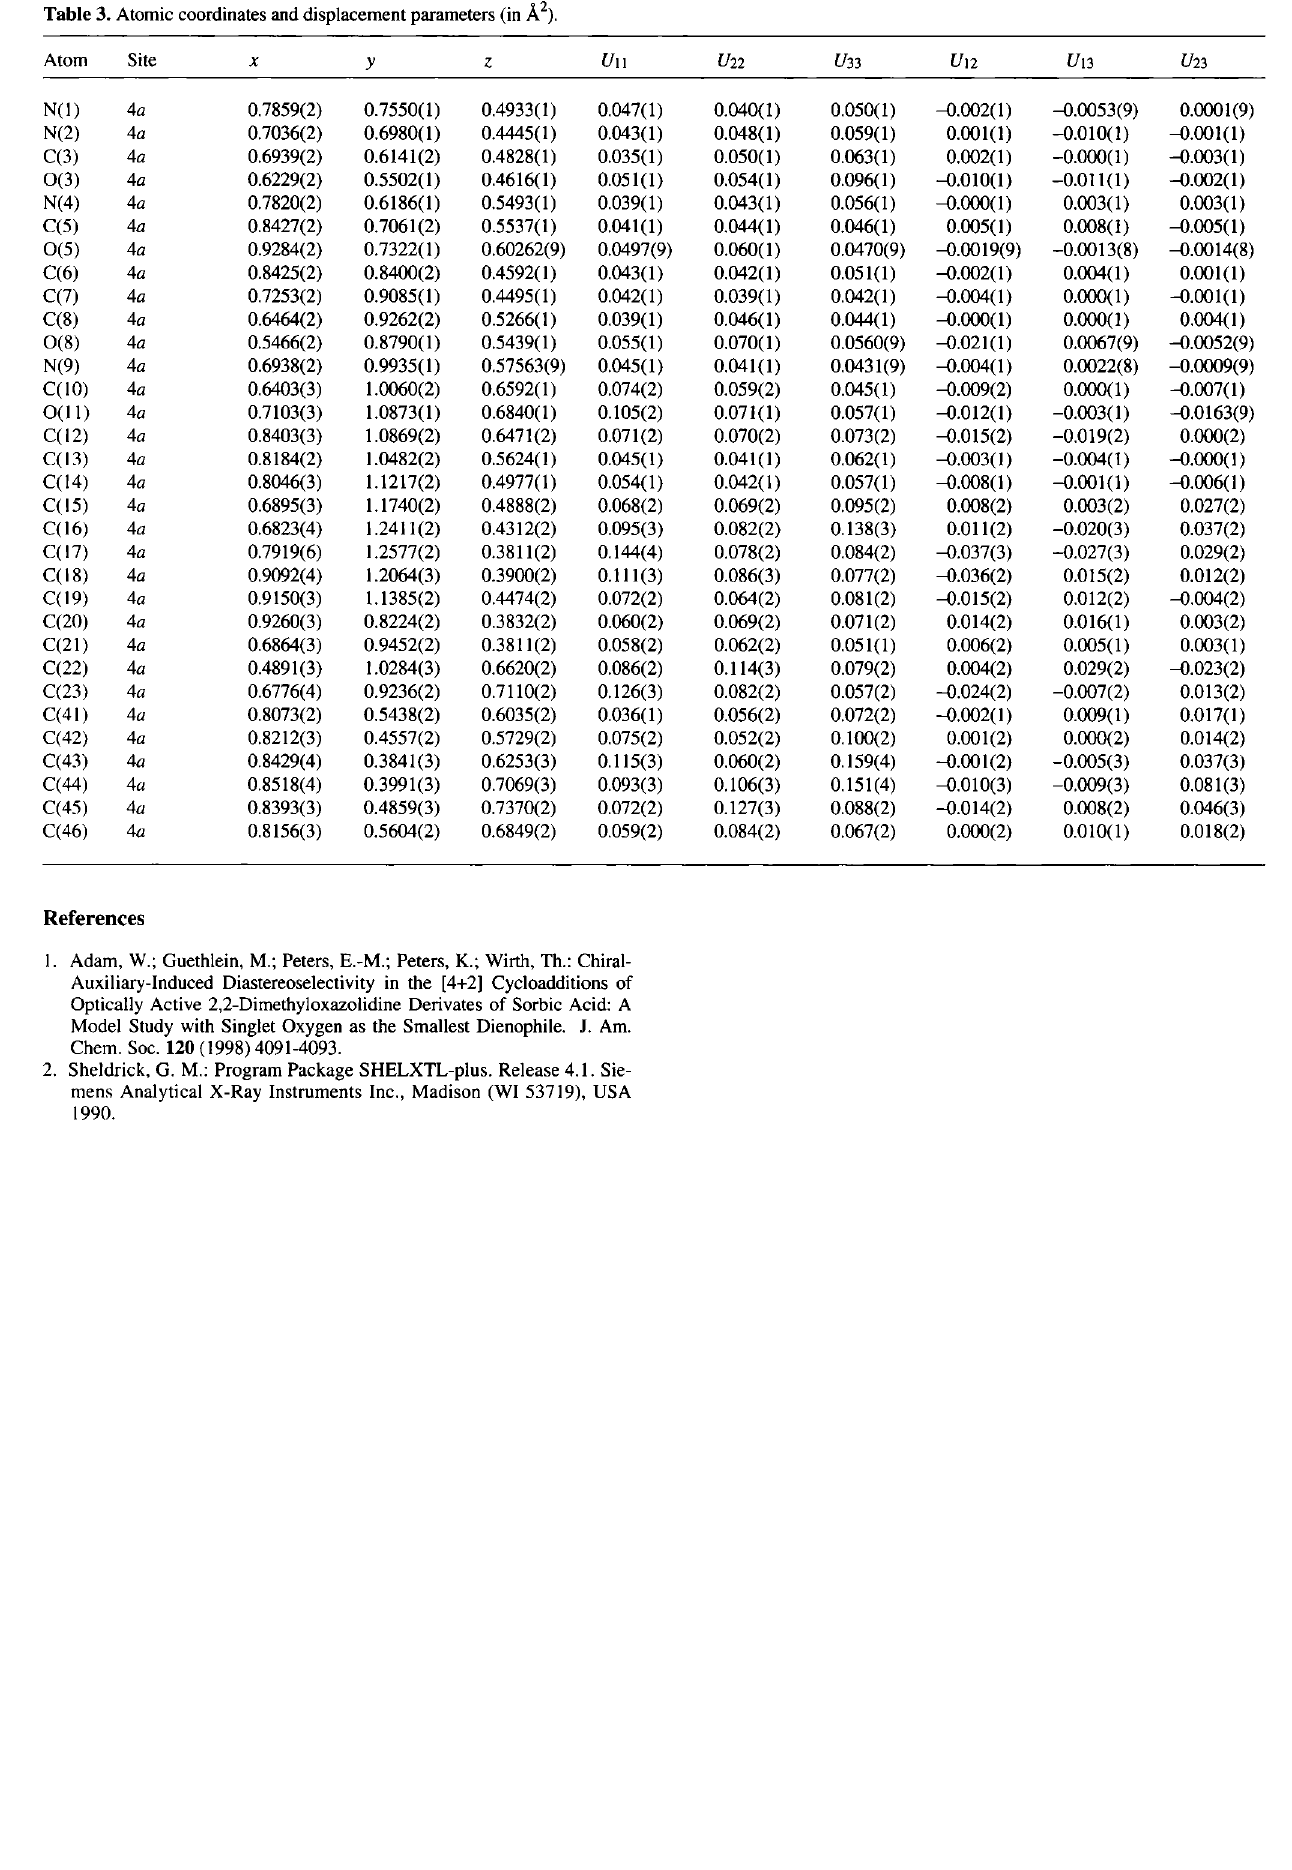
Table 3. Atomic coordinates and displacement parameters (in Â 2